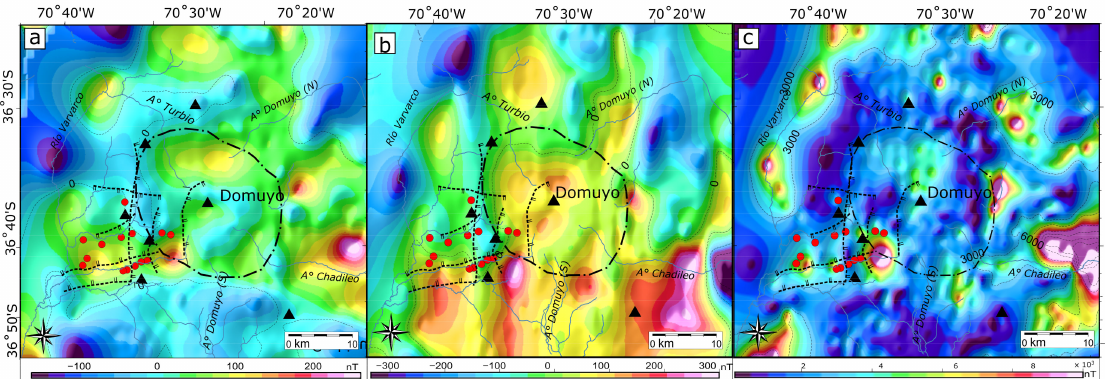
Figure 7. Magnetic anomalies in nT, ( a ) total magnetic anomaly, ( b ) reduced-to-the pole anomalies, and ( c ) analytic signal. The black dashed circle indicates the deformed area as shown by InSAR products, red dots represent the areas of hydrothermal activity, black triangles correspond to the main mountain peaks, and the black dashed lines delineate the principal neotectonic extensional structures over the